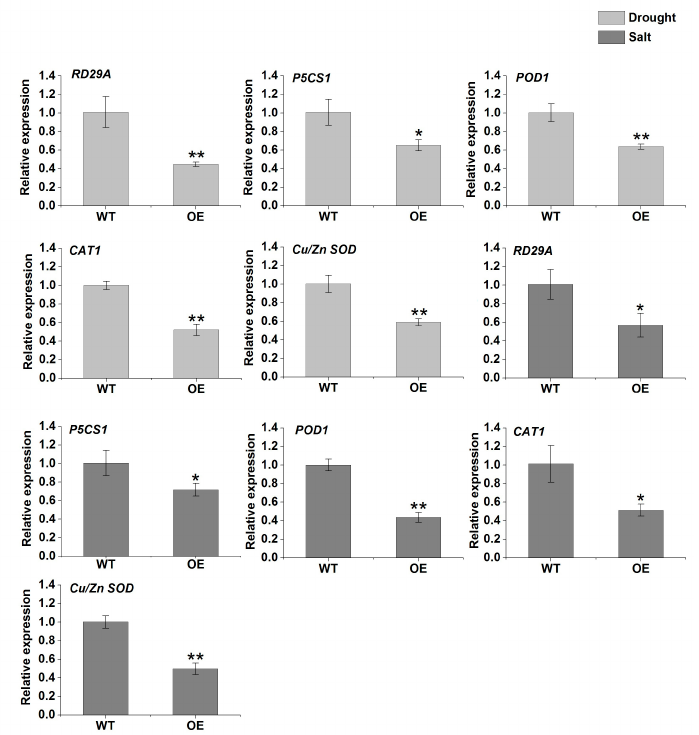
Figure 12. The expression profiles of stress-responsive genes ( RD29A , and P5CS1 ) and three antioxidant-related genes ( POD1 , Cu/Zn SOD and CAT1 ) in TaERF-6-3A transgenic Arabidopsis lines under drought and salt stress. Standard deviations are indicated by error bars (mean ± SD and n = 3) and significant differences are indicated using asterisks (ANOVA, * p < 0.05; ** p < 0.01).